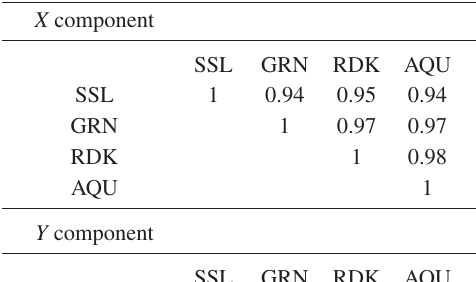
Table II. Mean cross-correlation coefficients. X component